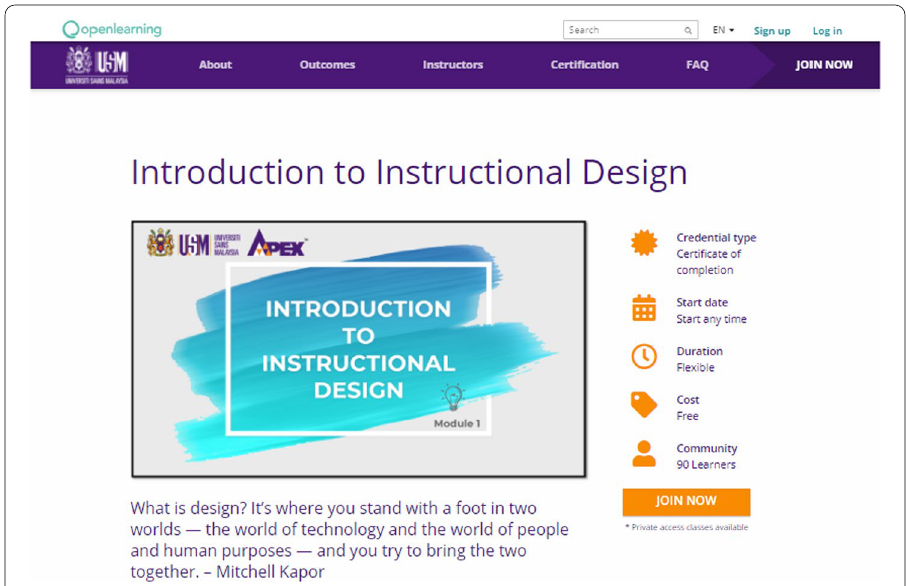
Fig. 1 Screenshot of the OpenLearning platform offering the